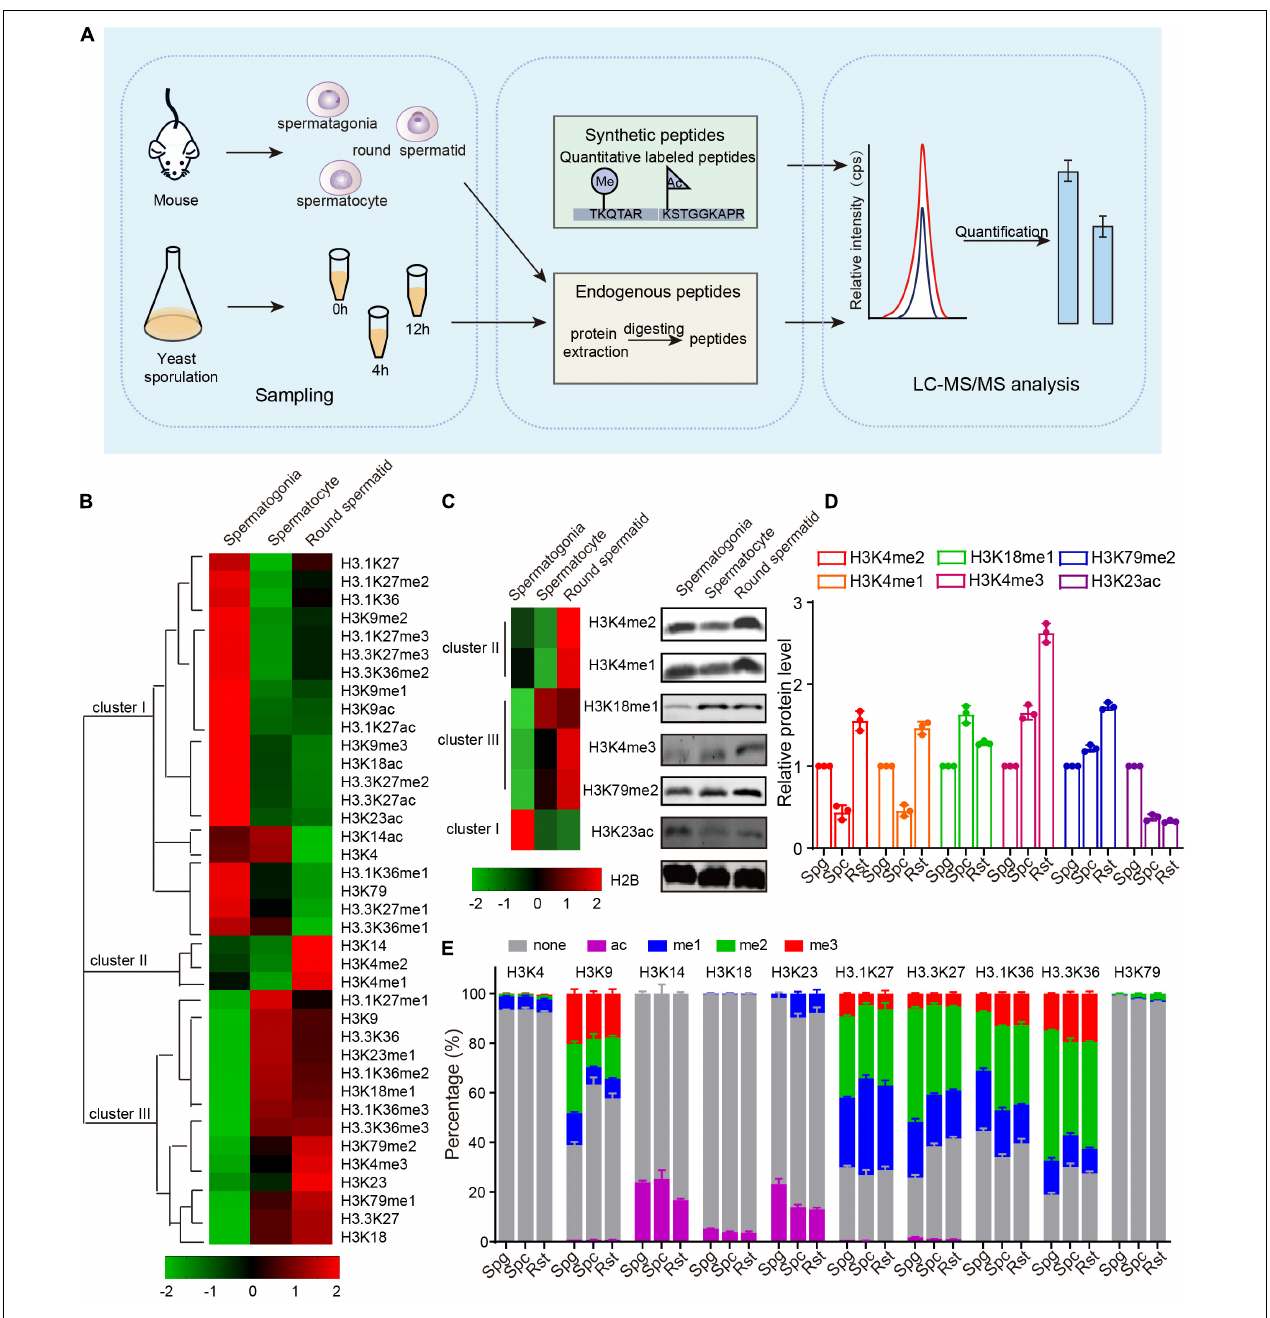
FIGURE 1 | Dynamic changes of mouse histone H3 modifications during spermatogenesis. (A) Schematic of MRM-based LC-MS/MS. (B) Hierarchical clustering analysis of histone H3 modifications during mouse spermatogenesis. (C) Western blot verification of MS data. Protein samples for both western blots and MS were extracted from mouse cells using the same methods. (D) Quantitative of the histone modifications level in C . The error bars indicate ± SD ( n = 3). Spg, spermatogonia; Spc, spermatocytes; Rst, round spermatids. (E) Relative abundance of histone modifications at histone H3 lysine sites for mouse MS samples. The error bars indicate ± SD (spermatogonia, n = 4; spermatocytes, n = 4; round spermatids, n = 3). Spg, spermatogonia; Spc, spermatocytes; Rst, round